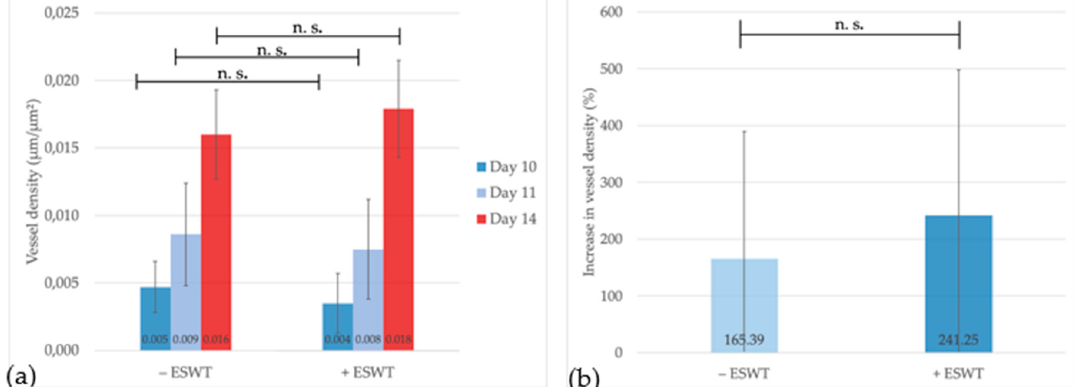
Figure 4. Vessel density analysis and comparison between treated and untreated groups within regions of interest (ROIs) over time. ( a ) The vessel density measured in different ROIs could be shown to increase between EDD-10 and EDD-14. No statistically significant difference could be shown between the ESWT-treated and the control group. ( b ) No significant difference could be shown regarding the increase of vessel density between EDD-11 and EDD-14, although there was a slightly greater increase within the ESWT group. Shown are means ± SD, n.s. = not significant. ( a ) Independent-Samples T-Test between experimental groups and untreated control, normally distributed, homogeneity of variance for EDD-10 and EDD-14; Mann-Whitney test, not normally distributed for EDD-11. ( b ) Mann-Whitney test, not normally distributed.